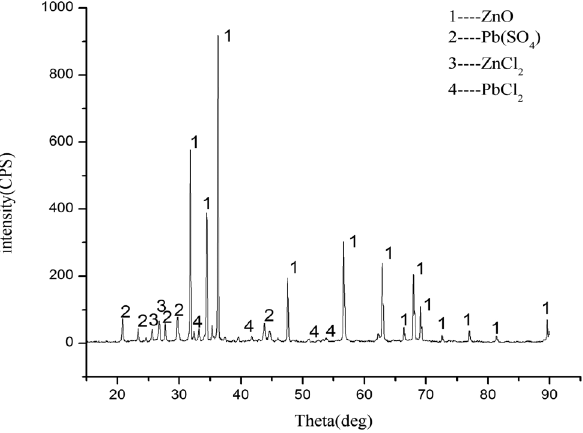
Fig. 3: XRD pattern of zinc oxide dust